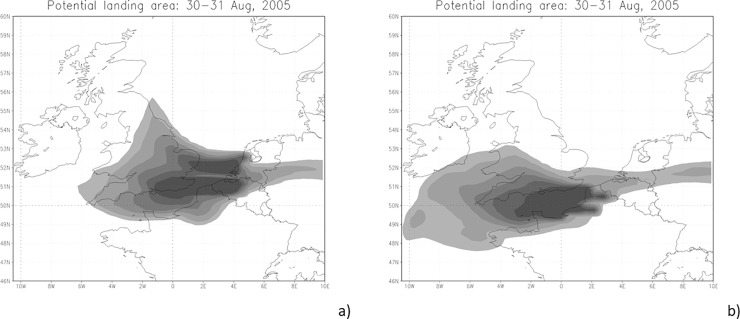
SILAM forward simulations.SILAM forward simulation on 30th August, 2005, 6 UTC - 31st August, 2005, 6 UTC. Source areas locate in a) Belgium and the Netherland and b) in France. Background maps OpenStreetMap contributors.